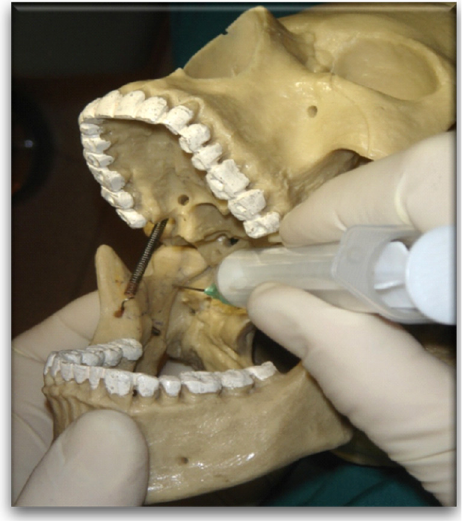
Figure 3. Local anesthesia bone landmarks on the plastic skull.